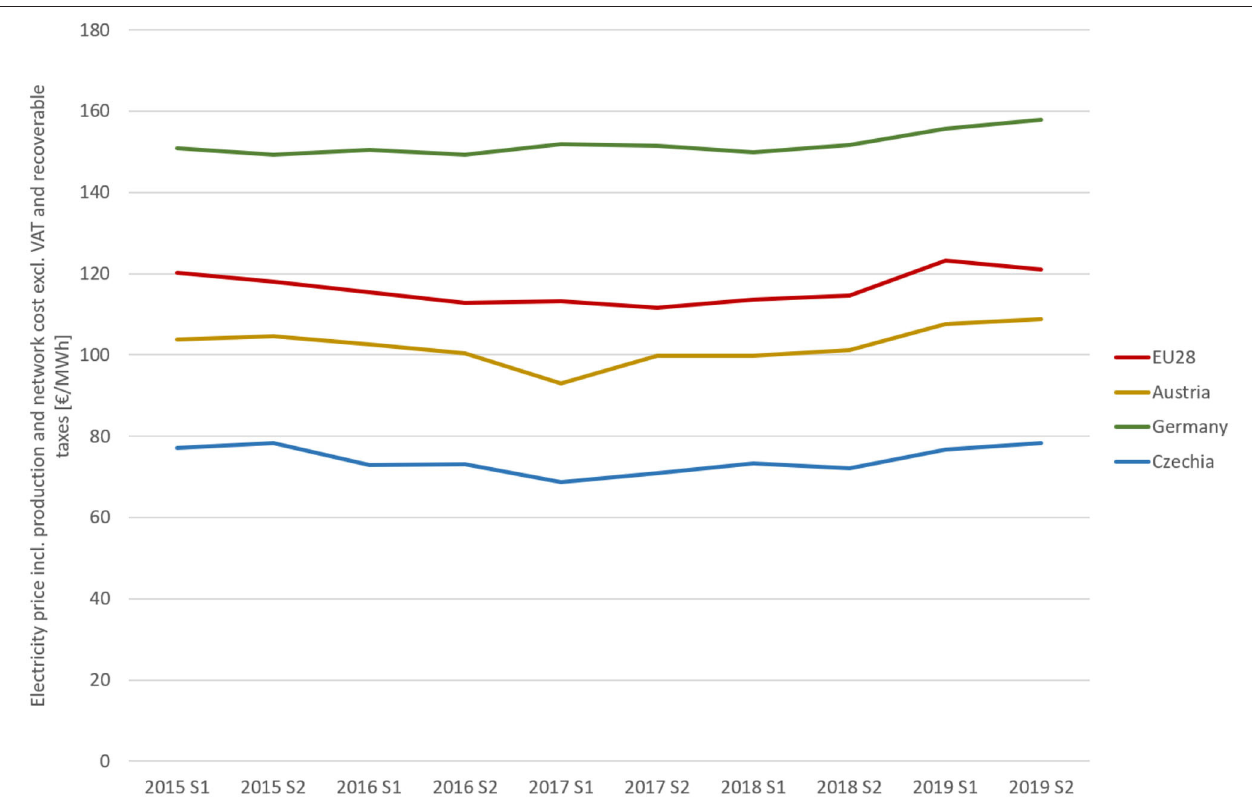
FIGURE 1 | Electricity price incl. production and network cost excle. VAT and other recoverable taxes for the half-years 2015–2019 for non-household consumers between 500 and 2,000 MWh/year ( Eurostat,